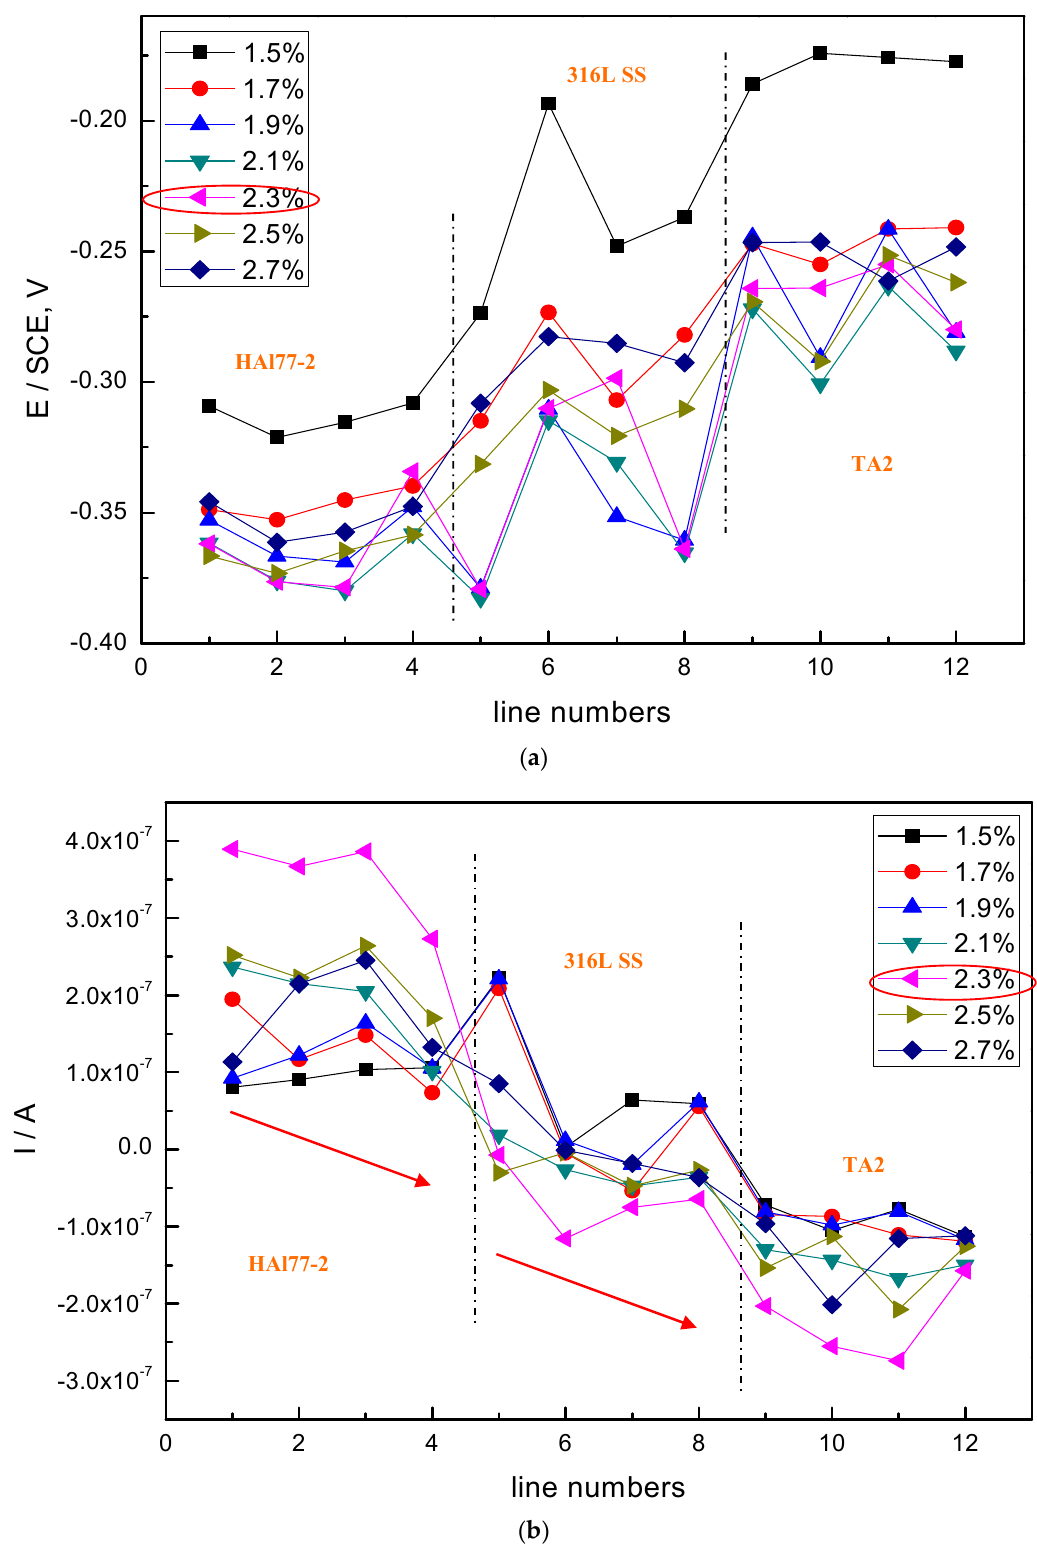
Figure 6. Potential and corresponding current distributions of each CMEA1 microelectrodes line after being short-circuited for 12 h in artificial seawater with different concentrations of chloride ions (wt %): ( a ) average potential; and ( b ) average current.